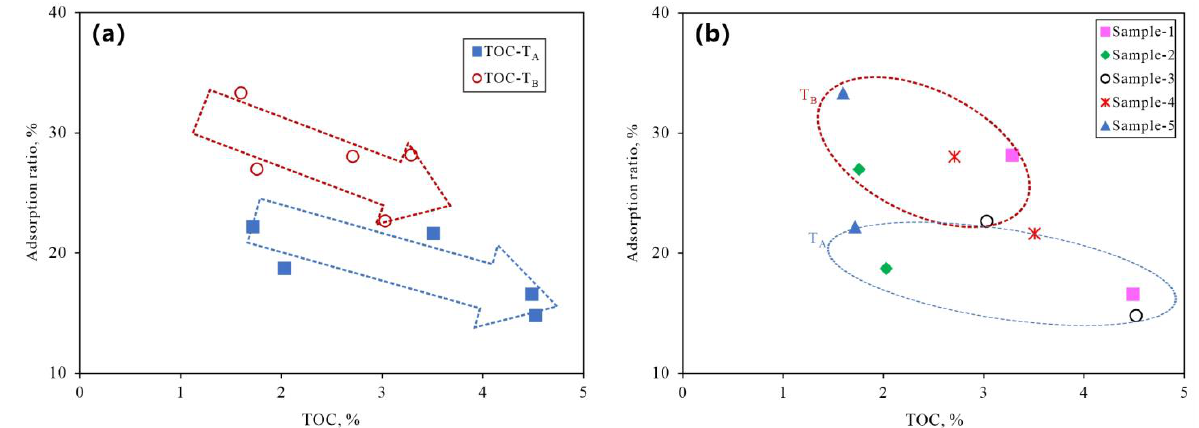
Figure 5. Relationship between the adsorption ratio of crude oil ( a ) and the TOC of adsorbents ( b ).